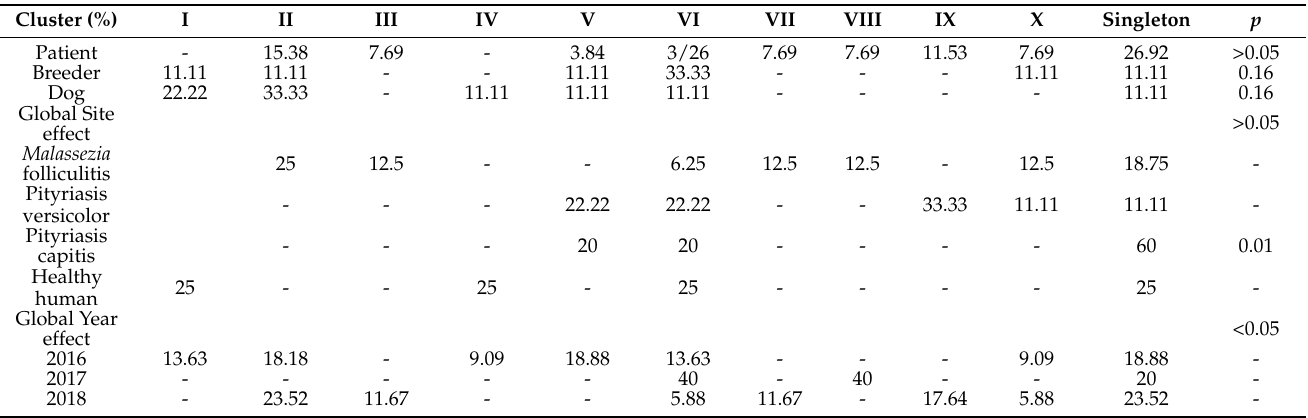
Table 3. Association of covariates with the ten Malassezia genetic clusters identified by minimum spanning tree (MStree)